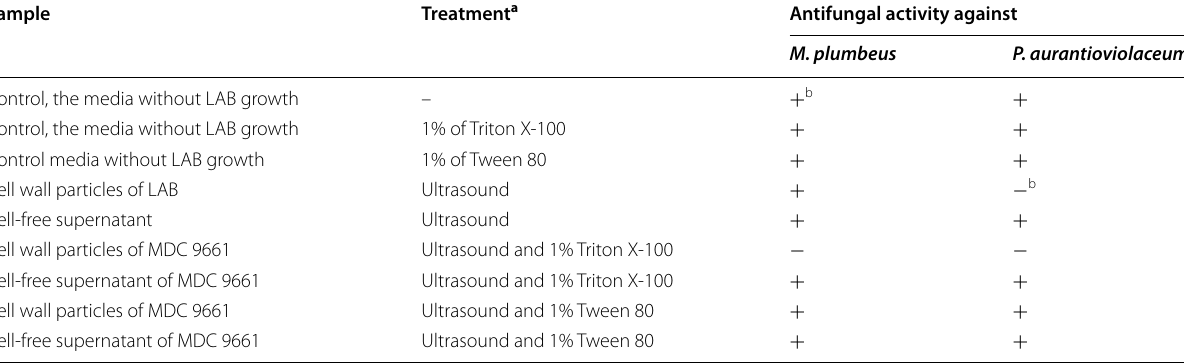
Table 3 The residual antifungal activity of L. rhamnosus MDC 9661 after the treatment with 1% Tween 80 and 1% Triton